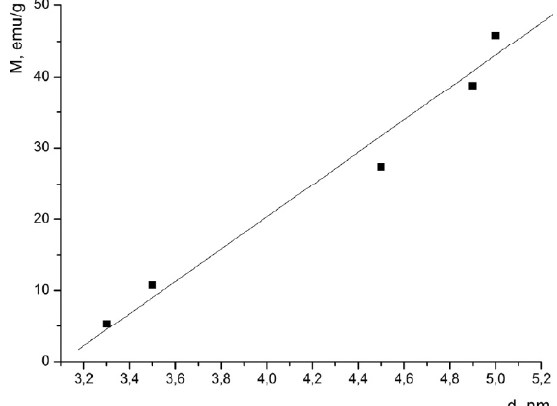
Fig. 3. The dependence of saturation magnetiza- tion of MCM-41/Fe on the matrix pores diameter (d).